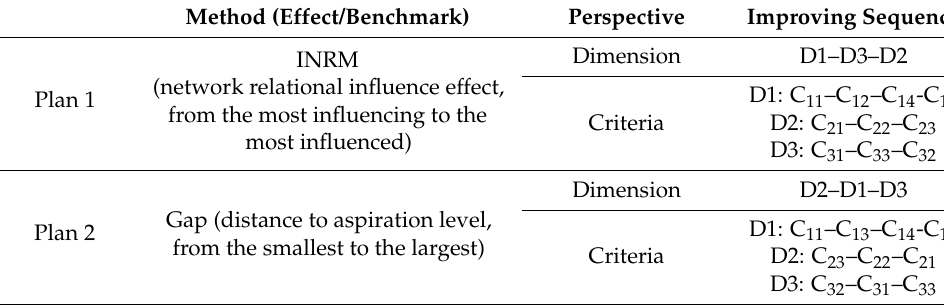
Table 9. Action plan for improving paid training tourism crisis